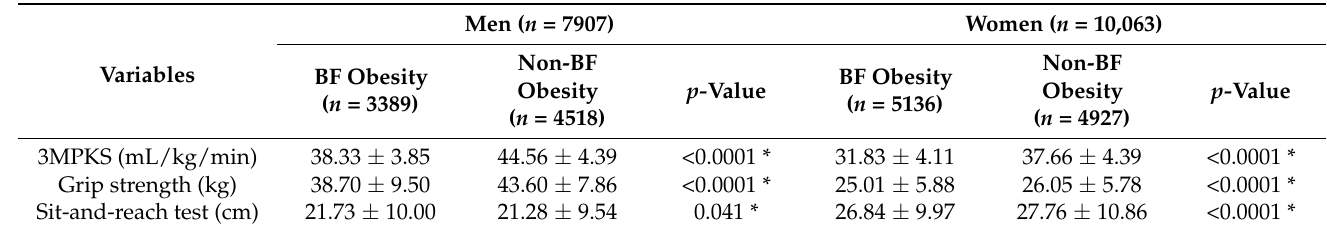
Table 2. Scientific physical fitness measurements on body fat obesity in Taiwanese adults.